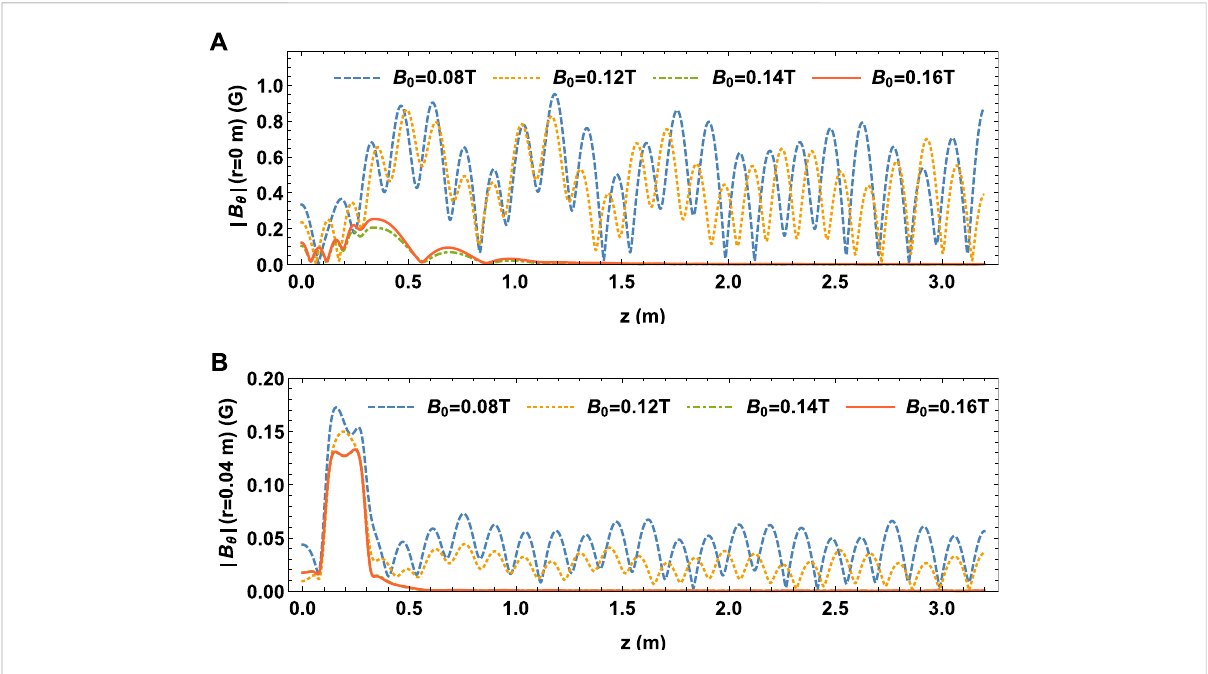
FIGURE 5 Axial pro fi les of wave magnetic fi eld for various con fi ning fi eld strengths, measured inside (A) , ( r = 0 m) and outside (B) , ( r = 0.04 m) blue-core